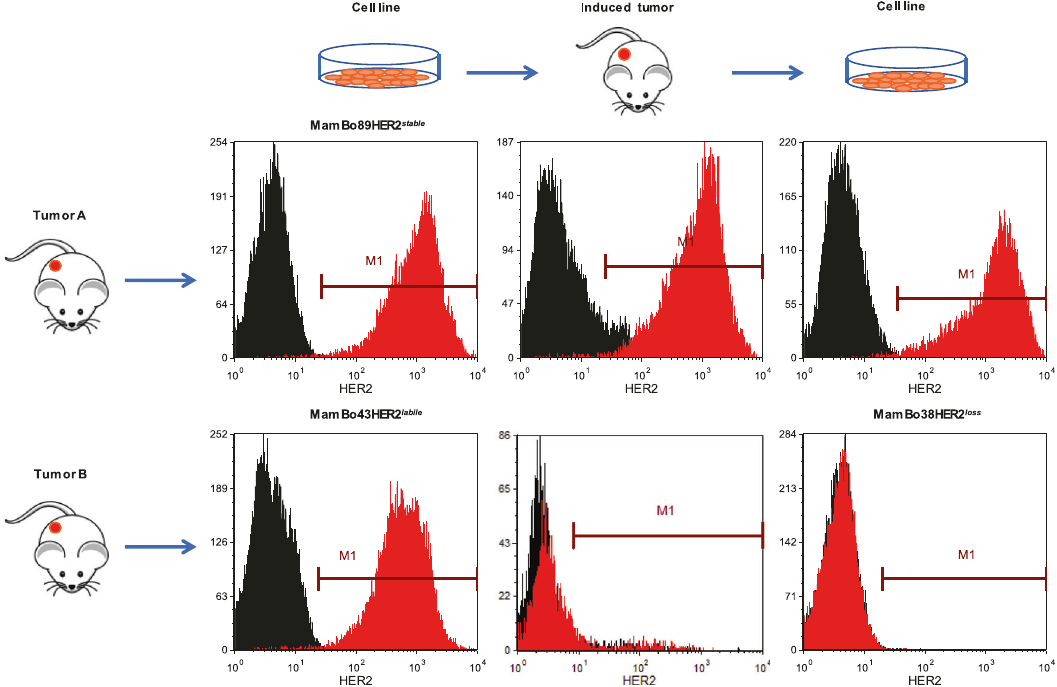
Fig. 1 MamBo cell lines and dynamic HER2 expression. Panels show representative pro fi les of HER2 level as measured by cyto fl uorimetric analysis. Black pro fi le, secondary antibody alone; red pro fi le, anti-HER2